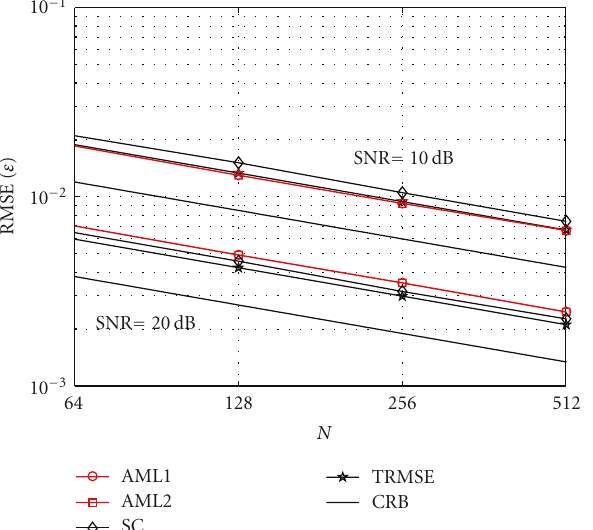
Figure 9: BER of the considered joint estimators in AWGN